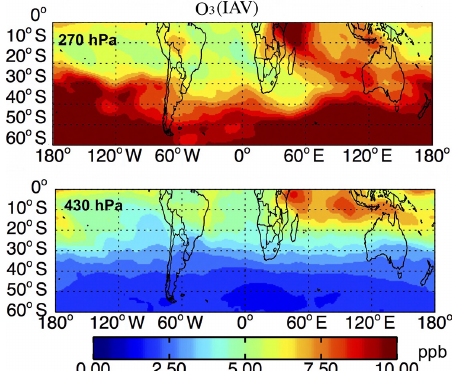
Figure 3. The interannual variations (IAV, unit of ppb) of simu- lated ozone at 270hPa (top) and 430hPa (bottom). The standard deviation of ozone anomalies (removing the monthly mean) over 1992–2011 represents the